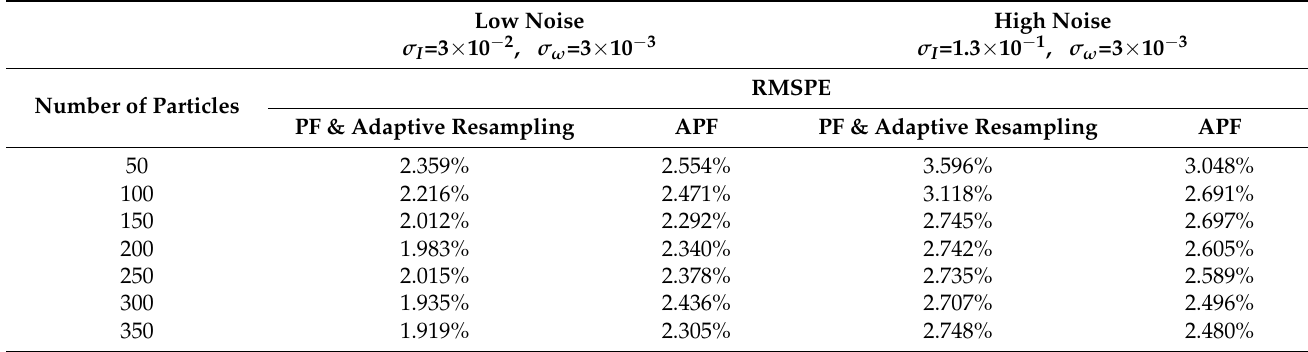
Table 5. Performance comparison for different types of estimation methods on T lub estimation.